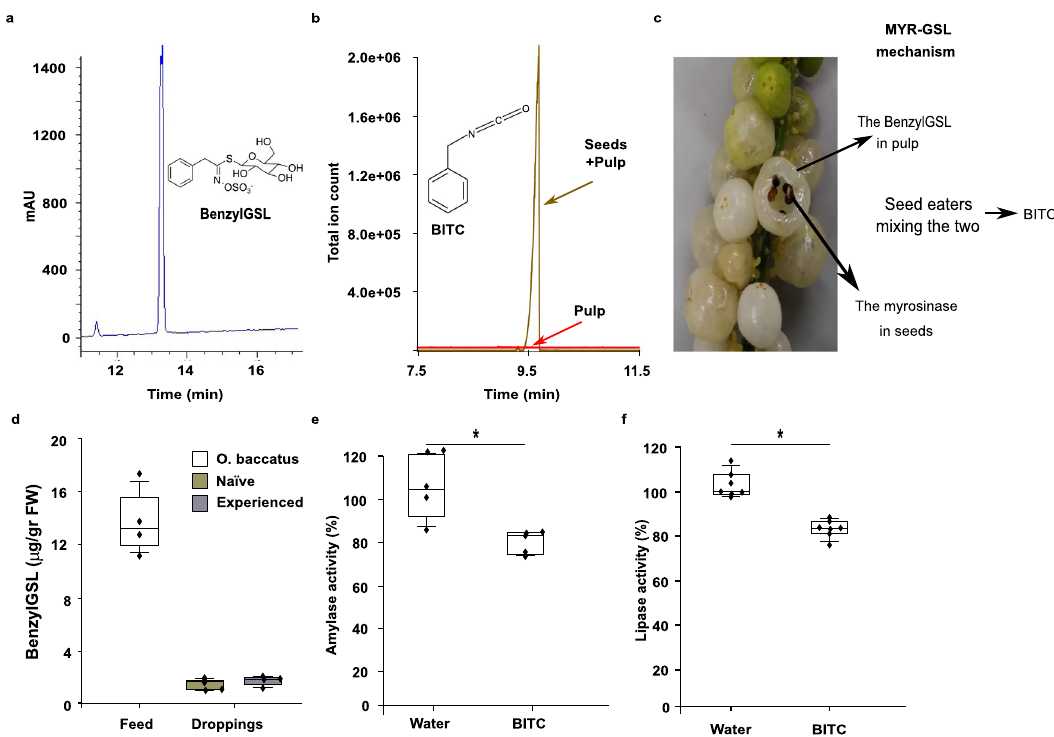
Fig.2|Mixing Ochradenusbaccatus seedsandfruitpulpactivatestheMYR-GSL mechanism and inhibits digestive enzymes. a HPLC chromatogram of glucosi- nolates (GSLs) in O. baccatus pulp juice identi fi es BenzylGSL as the main